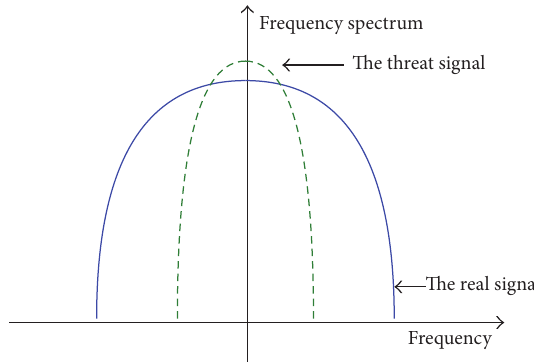
Figure 3: Threat signal with correlation characteristic.